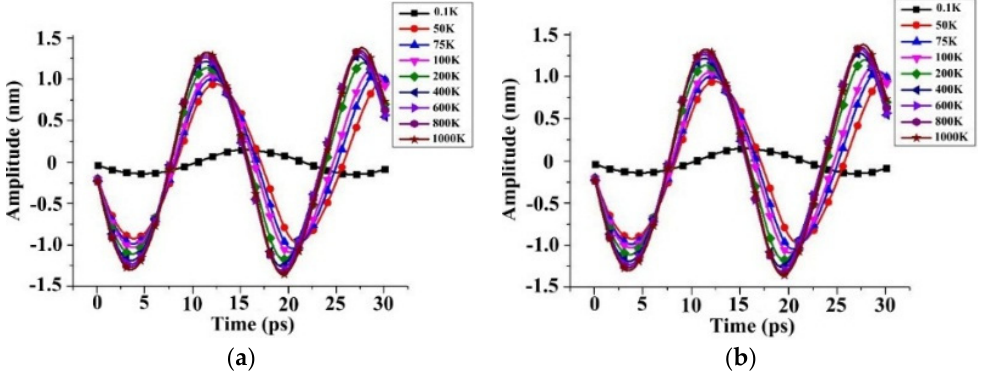
Figure 10. Absolute displacement in the normal direction at different system temperatures: ( a ) Single vacancy defect; ( b ) Edge defects.